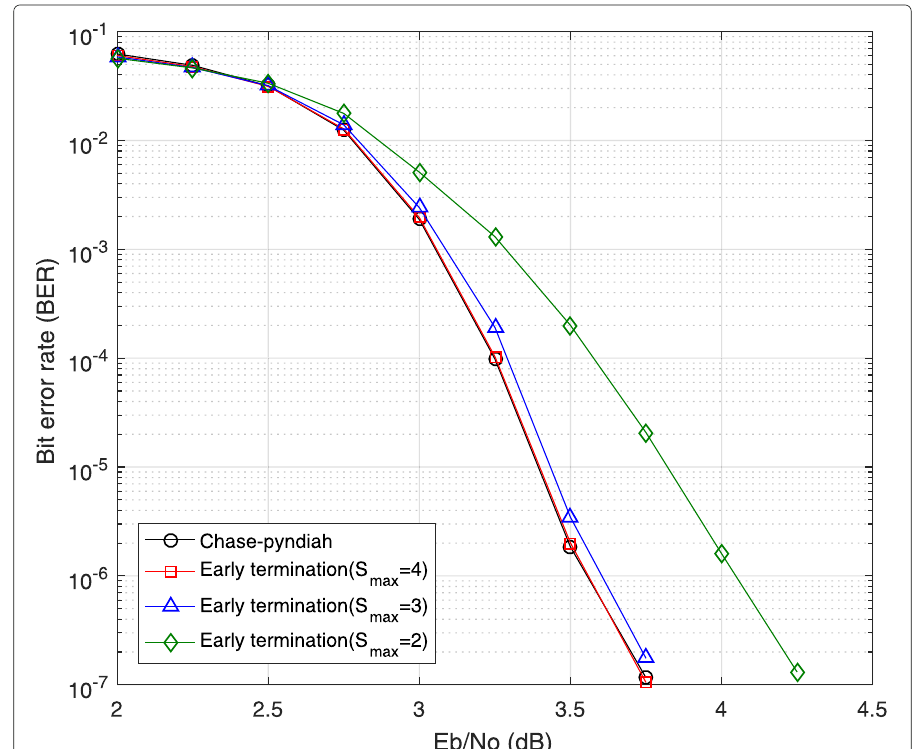
Fig. 7 Bit error rate performance results before and after applying the proposed early termination algorithm to ( 64,57,4 ) 2 TPC. I max ,8 (i.e., the number of maximum full-iterations, 4), LRB number, 4